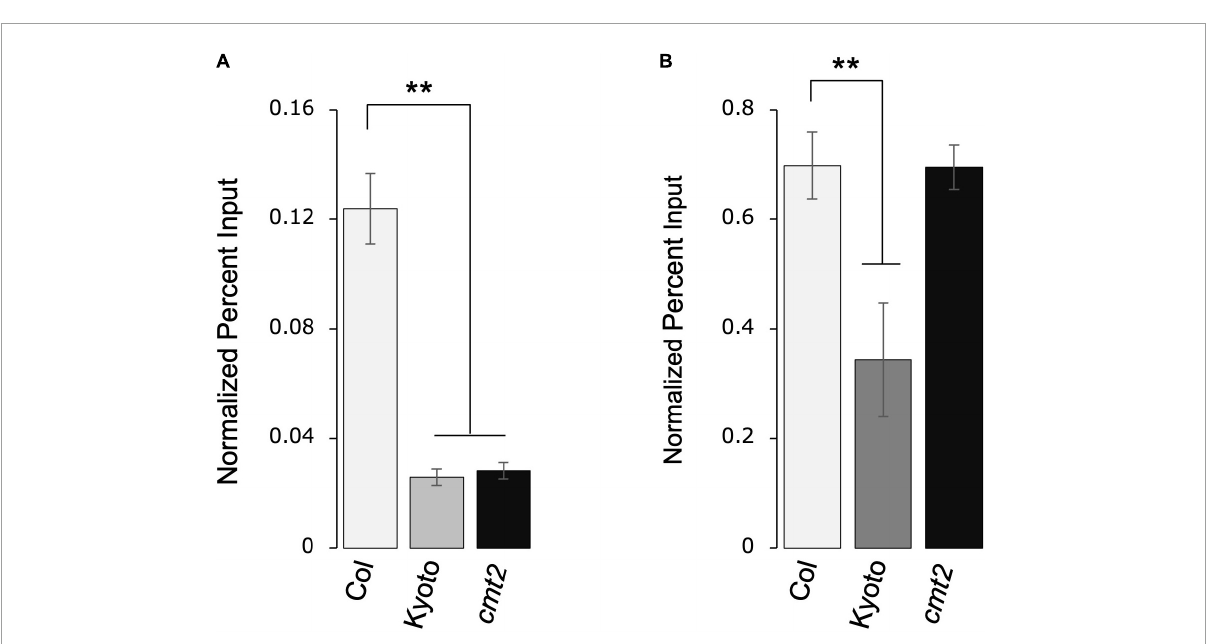
FIGURE6 ONSEN histone modification. Accumulation of H3K9me2 (A) and H3K27me1 (B) in ONSEN under normal growth conditions. Data were quantified using chromatin immunoprecipitation-real-time polymerase chain reaction. Values represent means ± SD from three biological replicates. Asterisks mark significant differences from